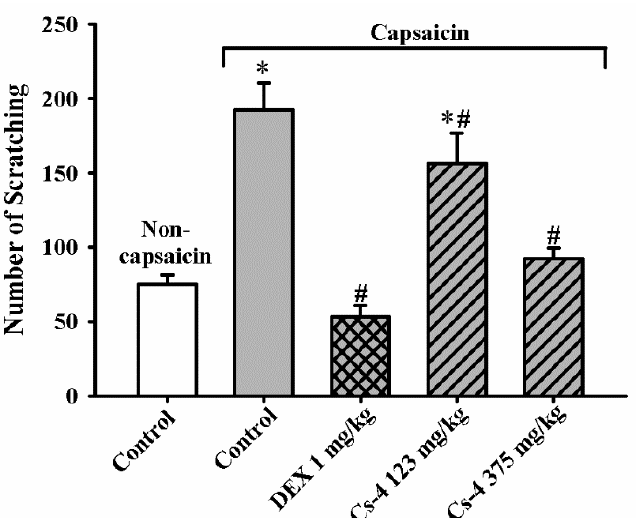
Figure 7. The effect of Cs-4 on the scratching behavior of capsaicin-challenged rats. The rat model of asthma was established, and scratching behavior was scored as described in the Materials and Methods. Each bar represents the mean ± S.E.M., with n = 8. * Significantly different from the noncapsaicin control group. # Significantly different from the capsaicin control group.